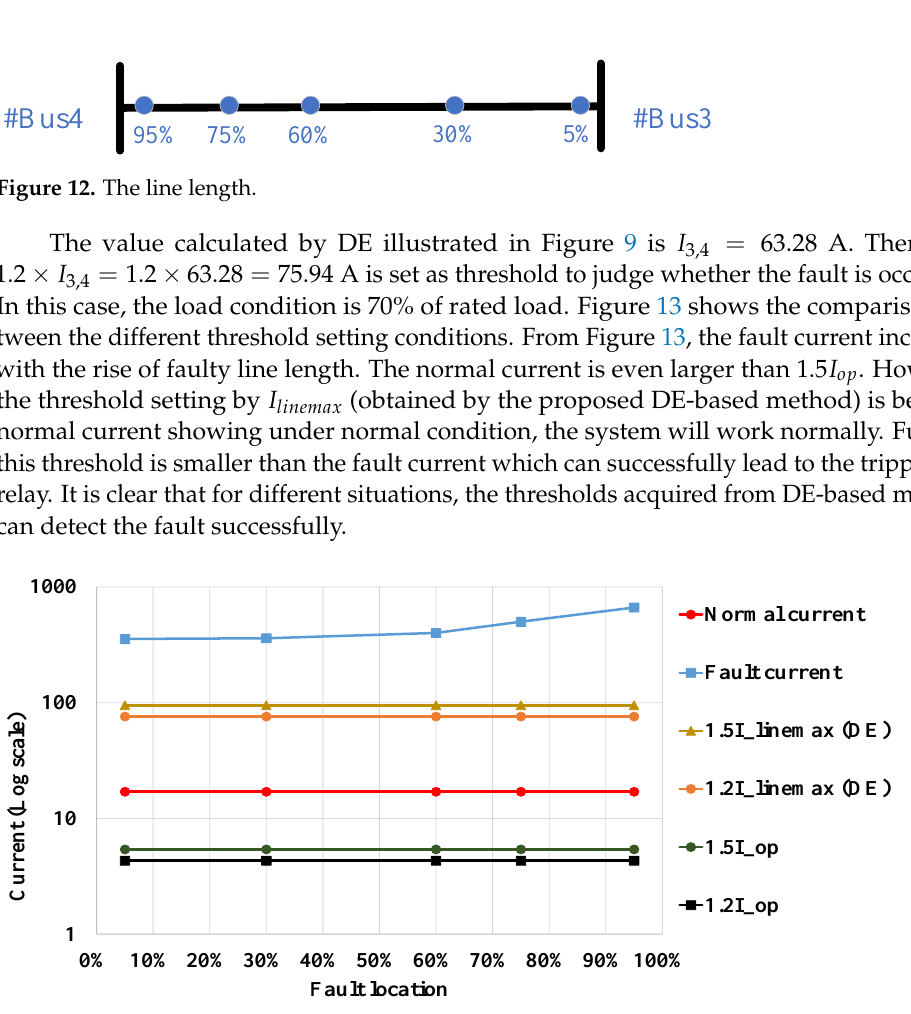
Figure 13. Fault condition at different locations with 70% load and 1 Ω fault